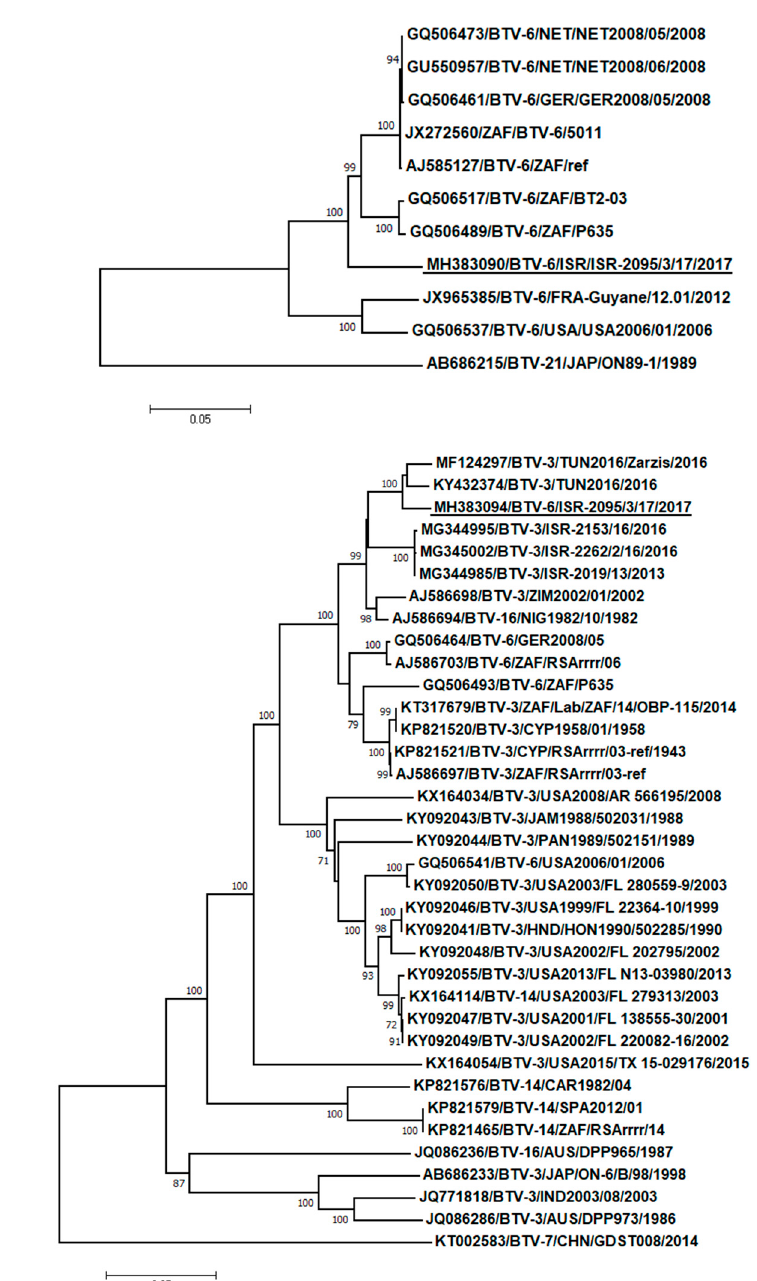
Figure 2. Phylogenetic analysis of Israeli BTV-6 strain with global BTV strains. ( a ) Segment 2 (VP2); ( b ) Segment 6 (VP5). The recent Israeli BTV-6 strain is underlined. Viruses were identified by accession number / serotype / location / isolate / year. The evolutionary history was inferred using the neighbor-joining method. The percentage of replicate trees in which the associated taxa clustered together in the bootstrap test (1000 replicates) with a percentage higher than 70 are shown next to the branches. The trees are drawn to scale, with branch lengths in the same units as those of the evolutionary distances used to infer the phylogenetic tree. The evolutionary distances were computed using the p-distance method and are in the units of the number of base di ff erences per site. Codon positions included were 1st + 2nd + 3rd + Noncoding. All positions containing gaps and missing data were eliminated.